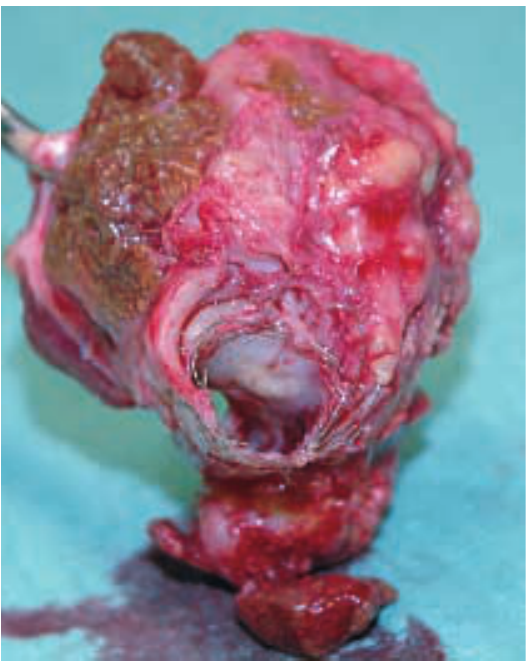
Figure 2 Resection specimen showing stent invasion.